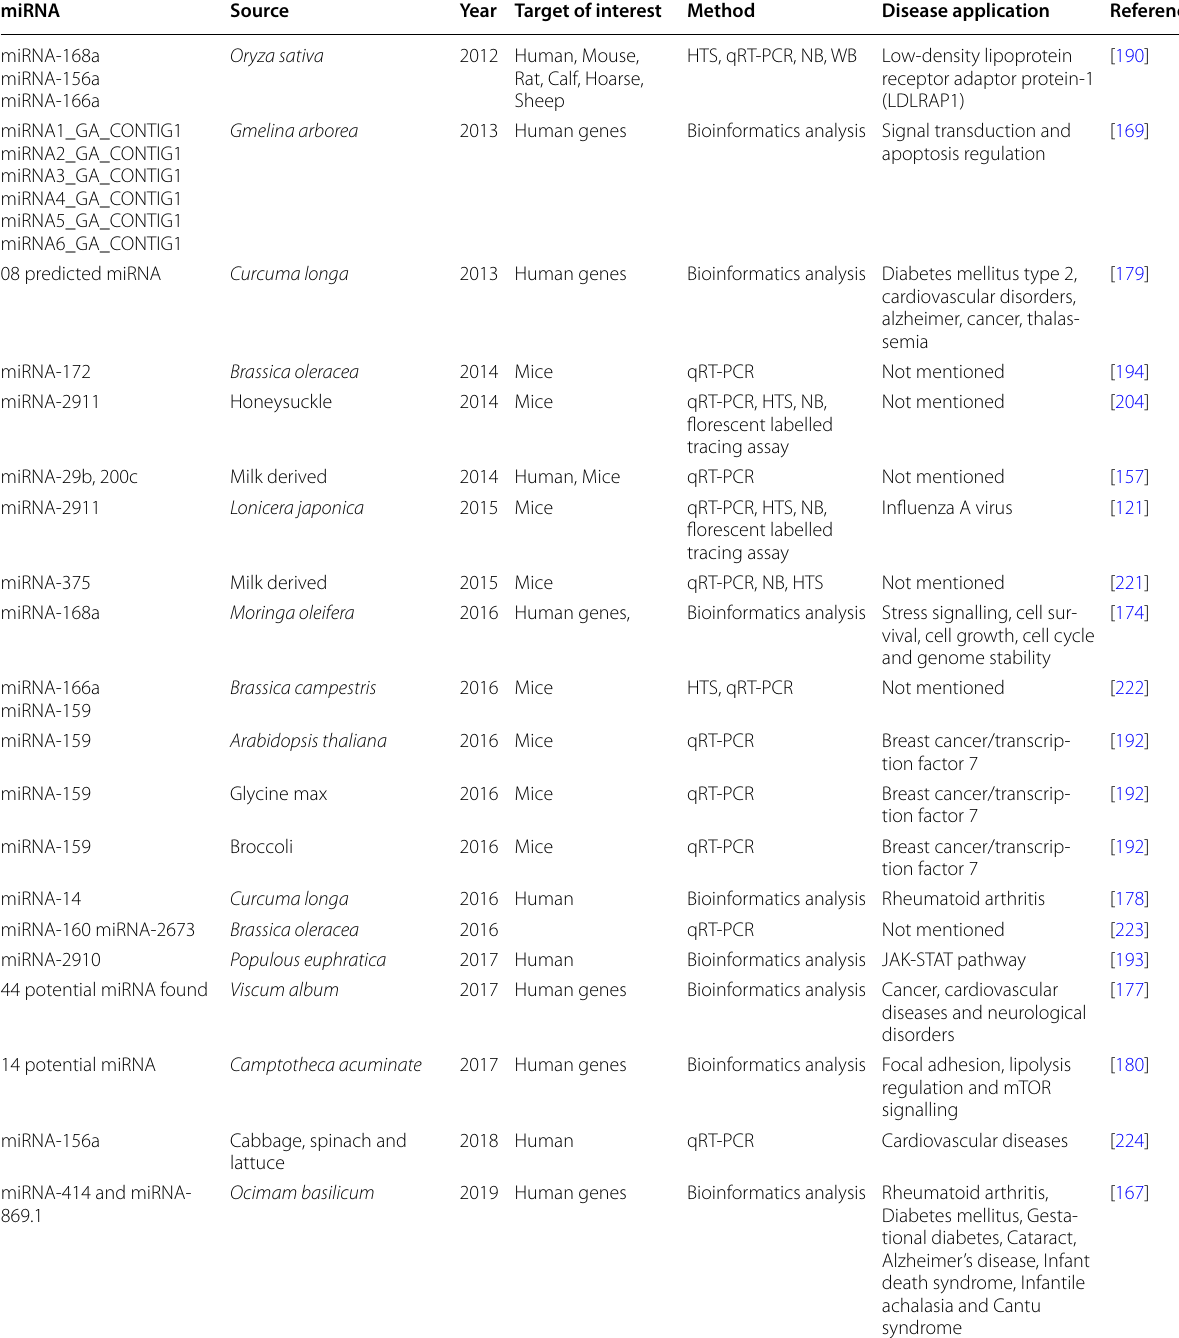
Table 4 Plant miRNAs in gene regulation: a cross-species comparison